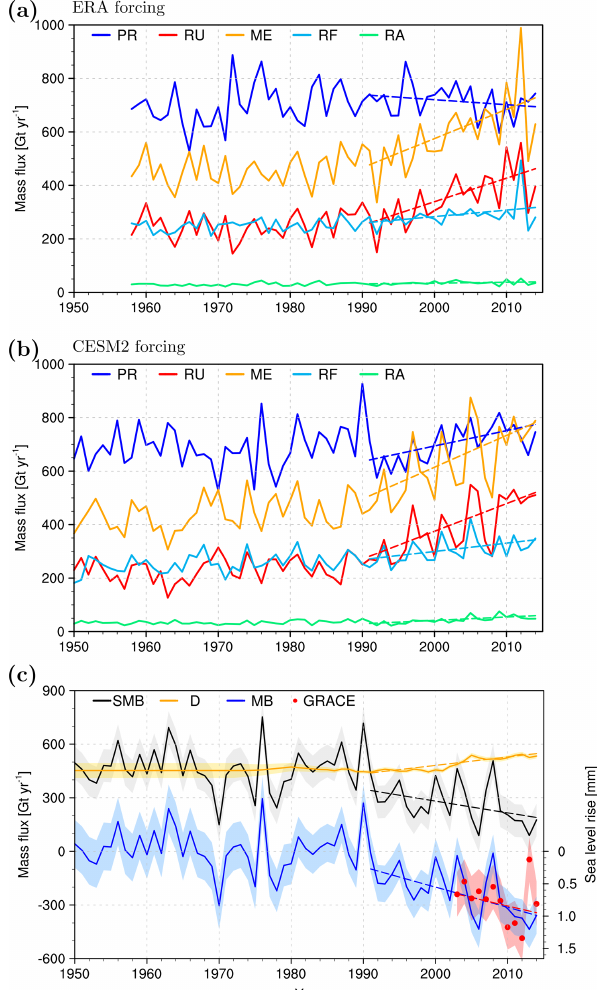
Figure 3. Time series of downscaled (1km) GrIS-integrated an- nual SMB components, namely total precipitation (PR; blue), runoff (RU; red), melt (ME; orange), refreezing (RF; cyan) and rainfall (RA; green), as modelled by (a) ERA-forced RACMO2.3p2 (1958– 2014) (Noël et al., 2019) and (b) CESM2-forced RACMO2.3p2 (1950–2014). (c) Time series of annual SMB (CESM2-forced RACMO2.3p2 at 1km), glacial discharge ( D ) (Mouginot et al., 2019) and mass balance (MB = SMB − D ). Mass loss from GRACE (2003–2014) is represented by red dots (Wouters et al., 2013). Dashed lines show the 1991–2014 trends. To enable a direct comparison with GRACE in (c) , SMB is integrated over the GrIS, peripheral ice caps and surrounding tundra regions of